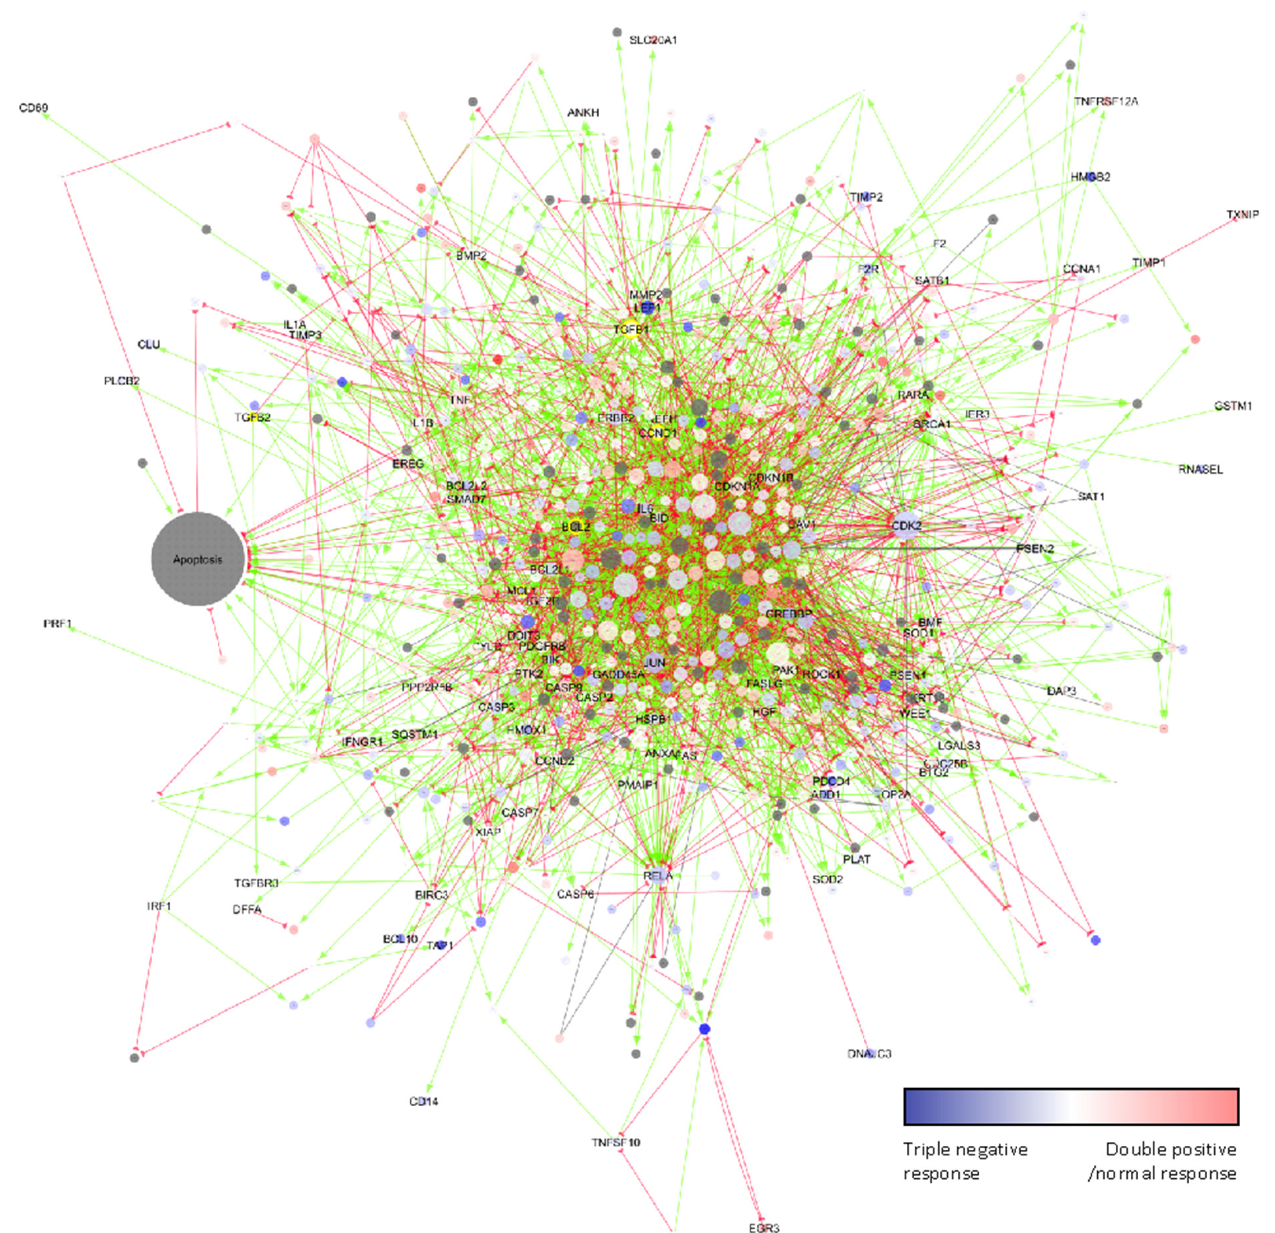
Figure 6. The effect of arsenate treatment on the apoptosis network and its interactors according to the SIGNOR database. Node size is according to degree. The colours are according to centroids above towards the TNBC cell lines. Grey proteins have no centroid values. Green arrows are up-regulating interactions; red half circle-ended lines are downregulating interactions. The effect of grey lines is unknown. High degree yellow bordered proteins are chosen to validate. They are central members of the network in apoptosis. Many high degree proteins such as LEF1 and CDK2 also respond to treatment in TNBC cell lines.